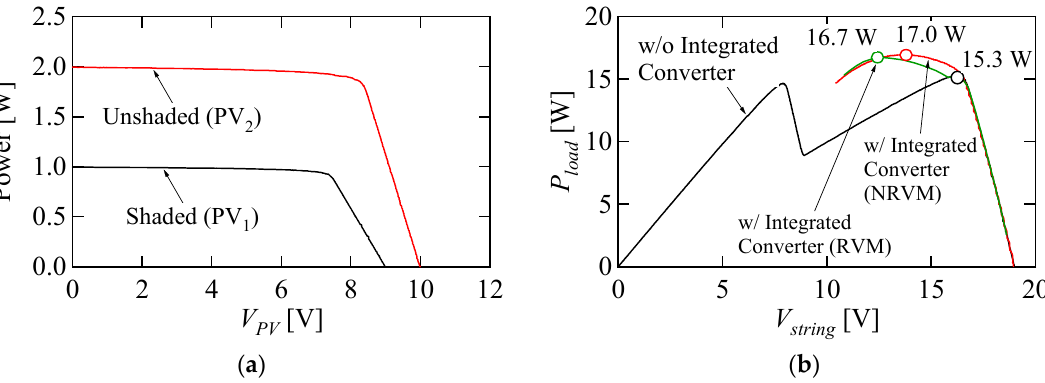
Figure 17. Experimental results: ( a ) Individual module characteristics, ( b ) measured string characteristics with/without integrated PWM converter.